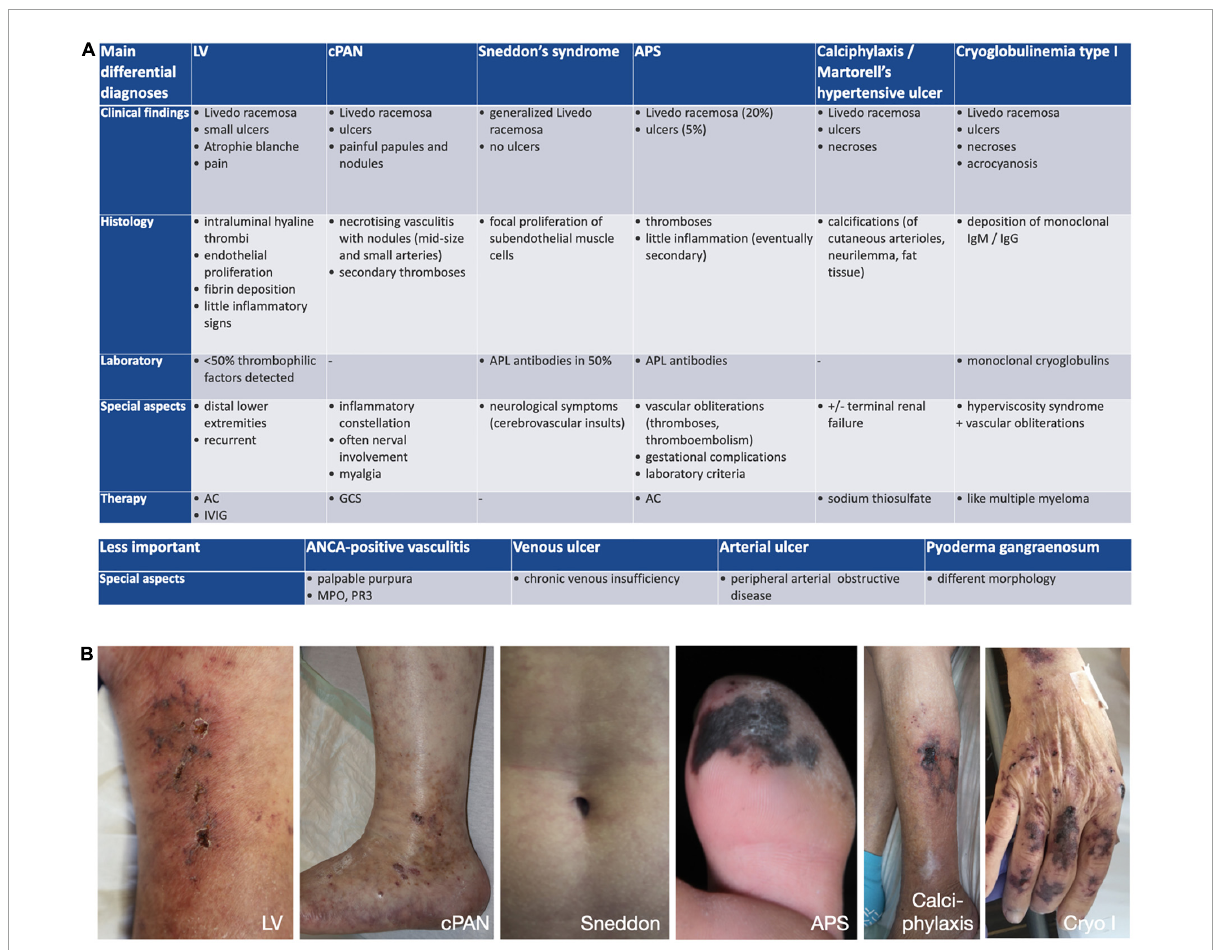
FIGURE9 (A) Differential diagnoses. AC, anticoagulation; ANCA, anti-neutrophil cytoplasmatic antibodies; APL, antiphospholipid; APS, antiphospholipid syndrome; cPAN, cutaneous Panarteriitis nodosa; GCS, glucocorticosteroids; IgG, immunoglobulin G; IgM, immunoglobulin M; IVIG, intravenous immunoglobulins. (B) Differential diagnoses – clinical examples. LV, livedoid vasculopathy; cPAN, cutaneous Panarteriitis nodosa; APS, antiphospholipid syndrome; Cryo I, cryoglobulinemia type